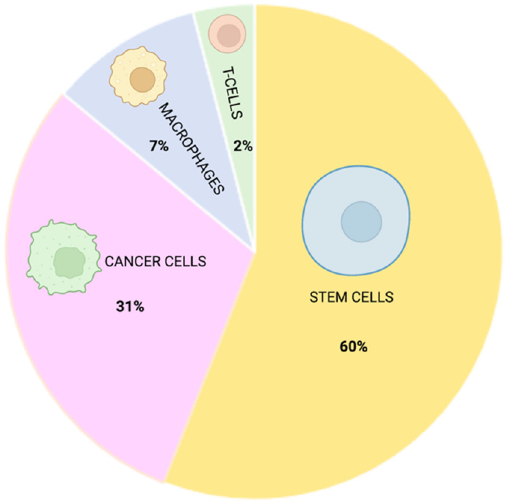
Figure 7. Cell sources adopted for efficient and safe NP delivery. Cell type subcategories and their relative percentage of utilization identified by the literature survey. Figure created with BioRender. Available online: https://biorender.com/ (accessed on 25 March 2022).